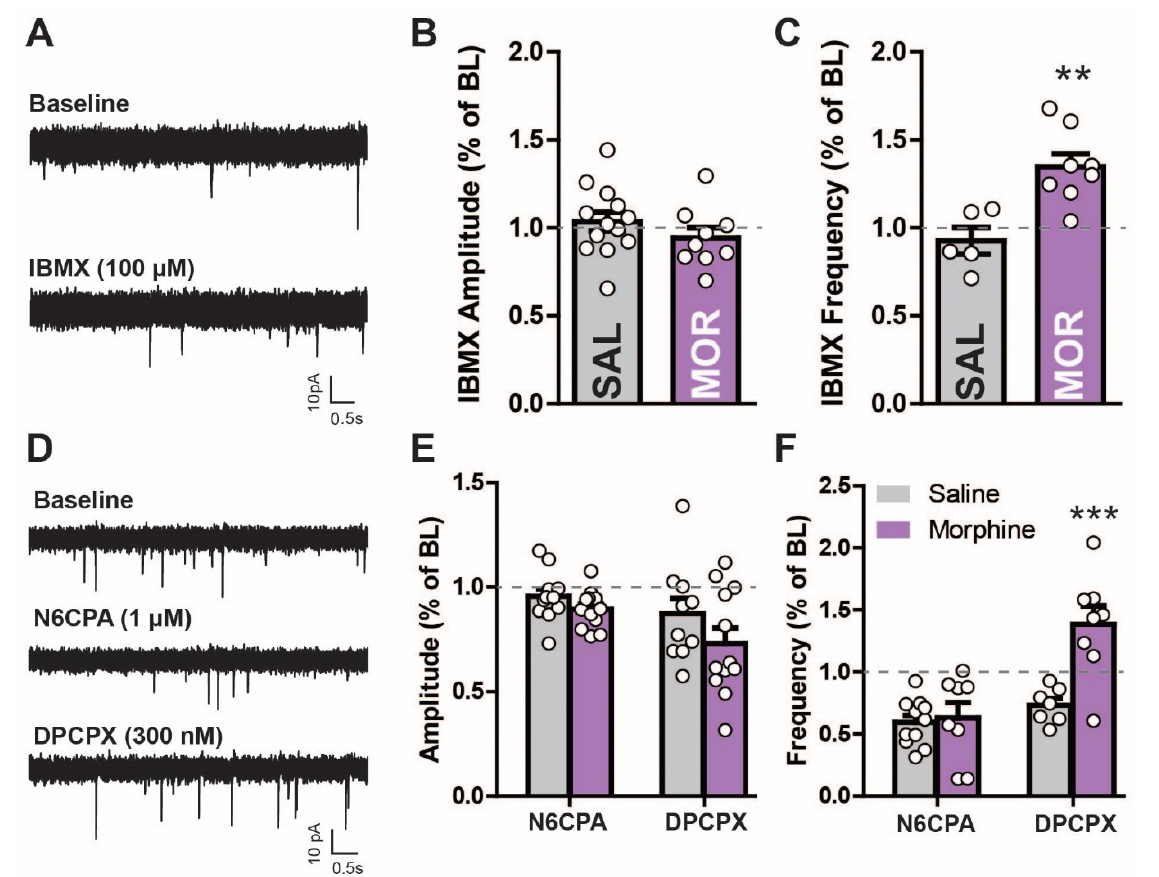
Figure 5. Morphine withdrawal increases cyclic AMP-dependent activity in lateral paracapsular (LPC) neurons. ( A ) Raw current traces from voltage clamp recordings in GABAergic LPC neurons measuring sIPSCs in saline- (IP, 7 days) and morphine-treated mice (10 mg/kg for 5 days, saline 2 days) in aCSF (baseline) and in the presence of the phosphodiesterase inhibitor IBMX (100 µ M) measuring sIPSC ( B ) amplitude and ( C ) frequency. IBMX increased frequency more in morphine- than saline-treated mice. ( D ) Raw current tracings of sIPSCs from voltage clamp recordings in GABAergic lateral paracapsular (LPC) neurons in saline- (IP, 7 days) and morphine-treated mice (10 mg/kg for 5 days, saline 2 days). The selective A 1 R agonist N 6 -cyclopentyladenosine (N6CPA; 1 µ M) was applied, followed by reversal with the antagonist 8-cyclopentyl-1,3-dipropylxanthine (DPCPX; 300 nM) while measuring sIPSC ( E ) amplitude and ( F ) frequency. sIPSC frequency increased to a greater extent after DPCPX in morphine- compared to saline-treated mice. ** p < 0.01, *** p <